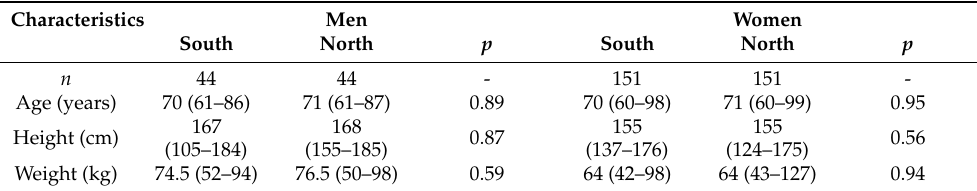
Table 1. Participants’ characteristics in median (minimum–maximum). Mann-Whitney non- parametric test